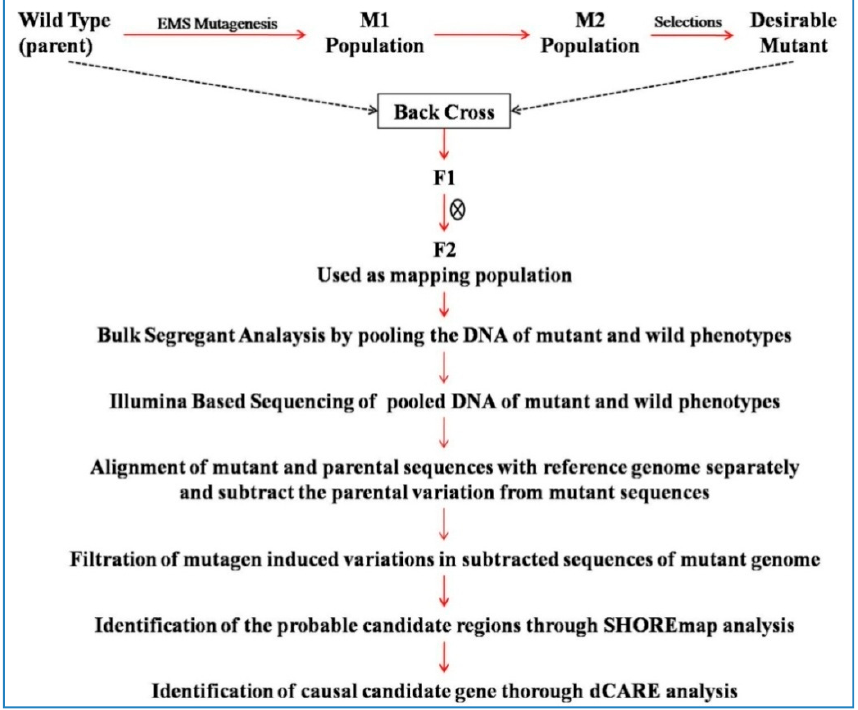
Figure 3. Flow diagram showing the major steps of deep CAndidate RE-sequencing (dCARE) approach of forward genetic screen.